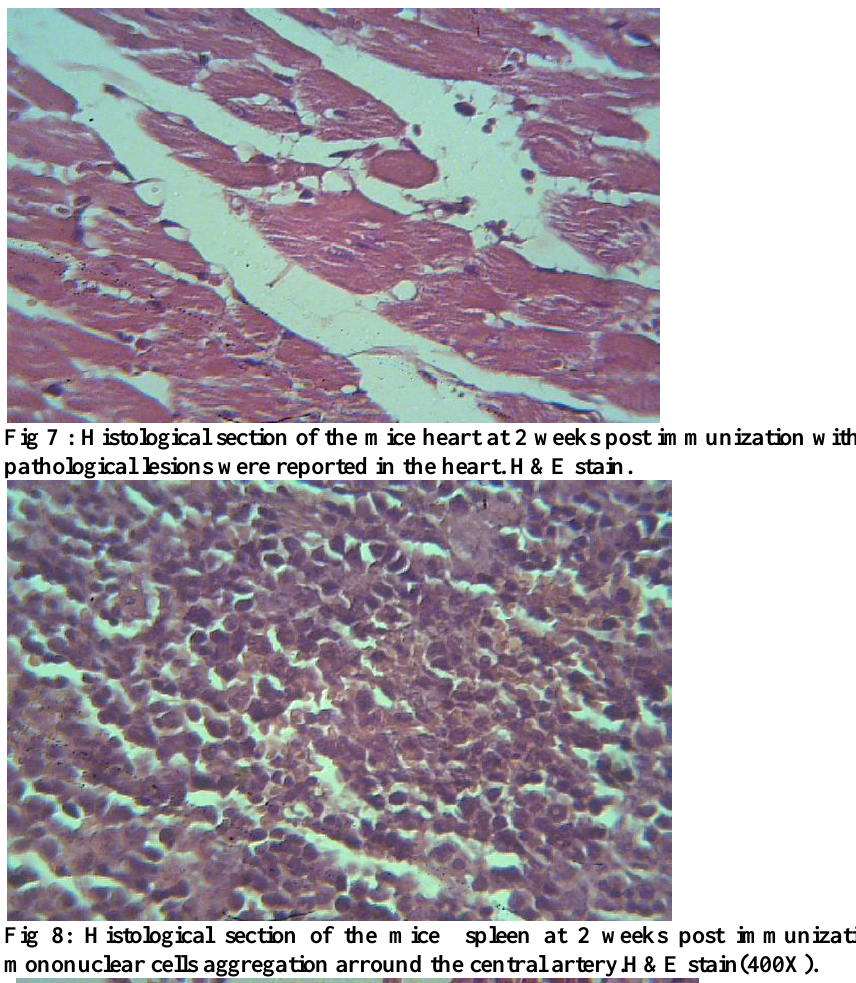
Fig 8: Histological section of the mice spleen at 2 weeks post immunization with HK-CA showed mononuclear cells aggregation arround the central artery.H&E stain(400X).